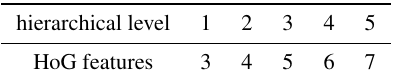
Table 2: Distribution of features used in the hierarchical detector with HoG features